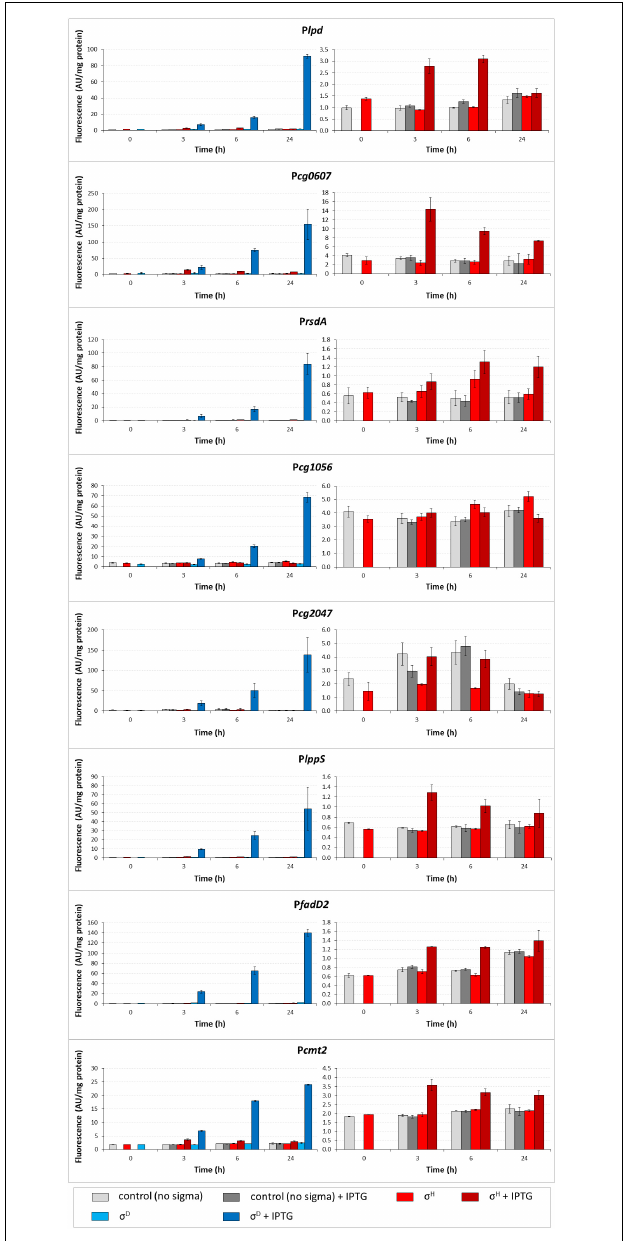
FIGURE 3 | Determination of promoter activity under sigD or sigH overexpression conditions using the two-plasmid assay. Promoter activity was measured as Gfpuv fluorescence intensity of cell extracts shown as bars in colors representing respective sigma factors. The C. glutamicum strains carried the pEC-XT99A constructs overexpressing sigD (blue bars) or sigH (red bars) after IPTG addition (added at time point 0, dark bars) and the promoter-test vector pEPR1 carrying the reporter gfpuv gene downstream of the target promoter (P lpd , P cg0607 P rsdA , P cg1056 , P cg2047 , P lppS , P fadD2, or P cmt2 ). The strains harboring the pEPR1 with the target promoters and empty pEC-XT99A were used as the controls (gray bars). Only the σ H -induced activity and controls are shown in the right panels to emphasize the minor recognition of σ D -controlled promoters by σ H . The background fluorescence intensity with control cells only carrying the empty vector pEPR1 was 0.25 ± 0.09 in all cases. AU, arbitrary units. The standard deviations of three biological replicates are depicted by error bars.